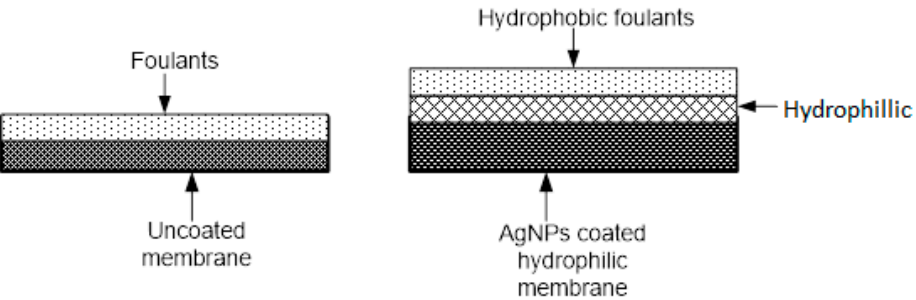
Figure 4. Mechanism of antifouling in uncoated and AgNP-impregnated membranes. Adapted from [5] .